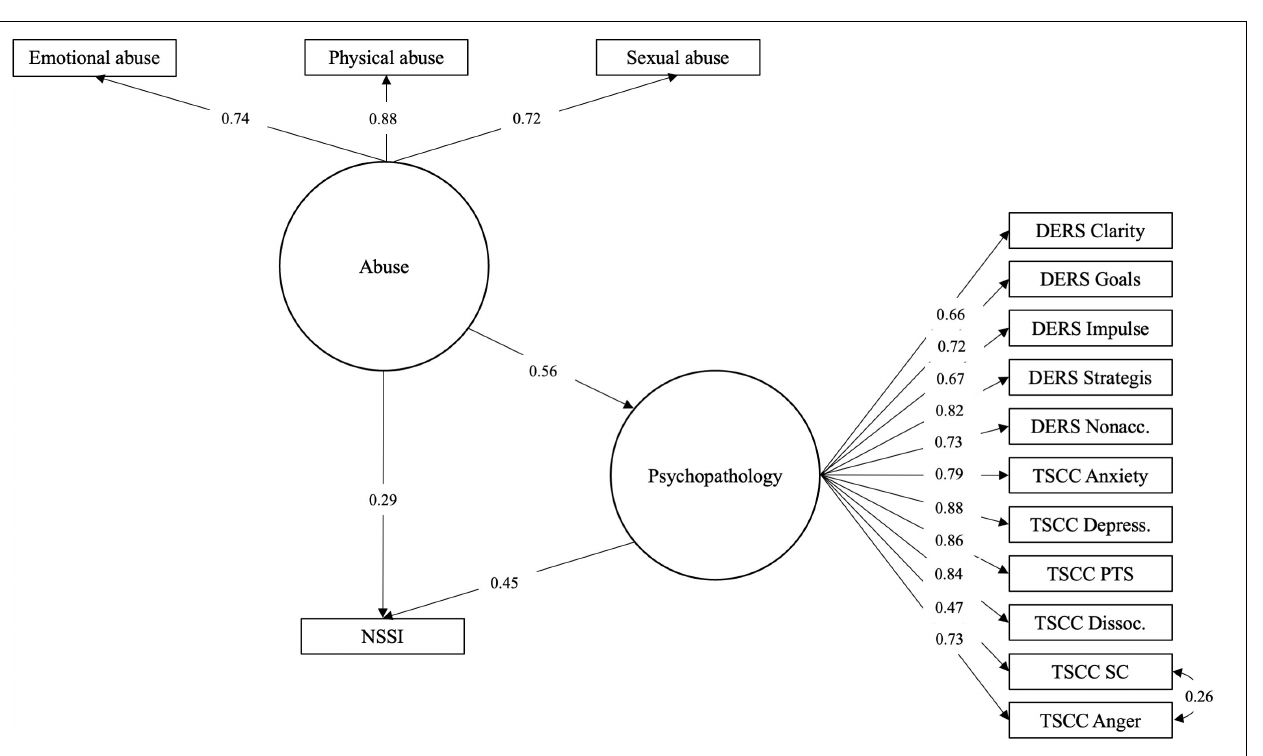
FIGURE 7 | Model 3d: Latent variable model of abuse effect on NSSI risk mediated by general ED/TS